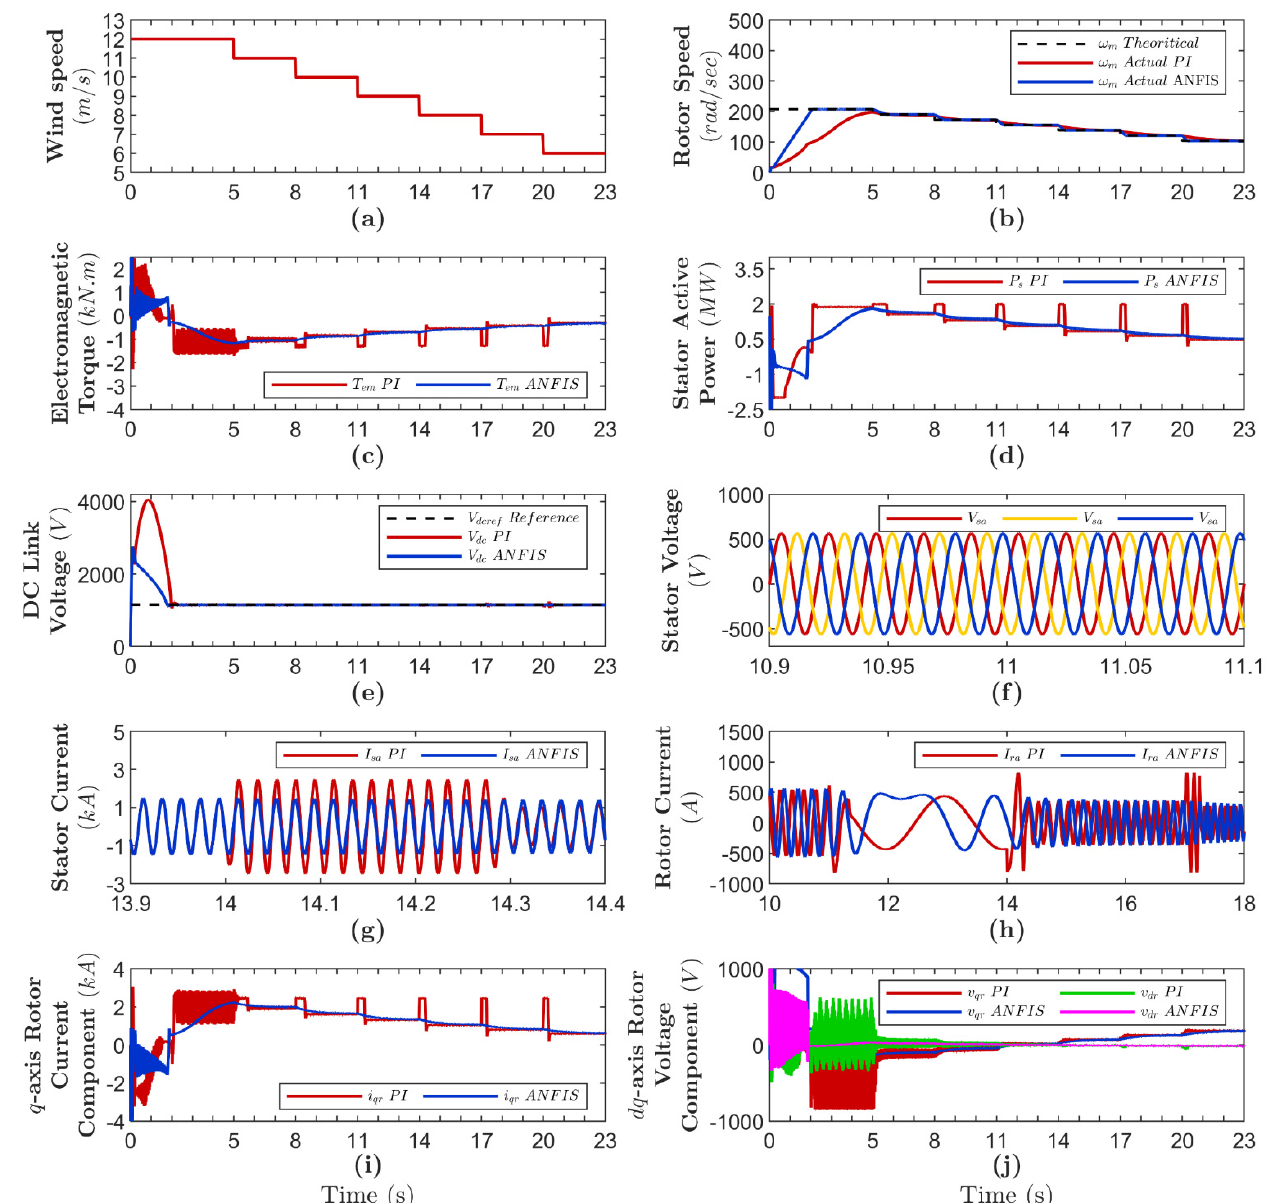
Figure 13. Simulated response under step wind speed decrease: ( a ) Input wind speed. ( b ) Rotor speed. ( c ) Electromagnetic torque. ( d ) Stator active power. ( e ) DC-link voltage. ( f ) Stator voltage. ( g ) Stator current of a-phase. ( h ) Rotor current of a-phase. ( i ) q -axis rotor current component. ( j ) d and q axis rotor voltage component.